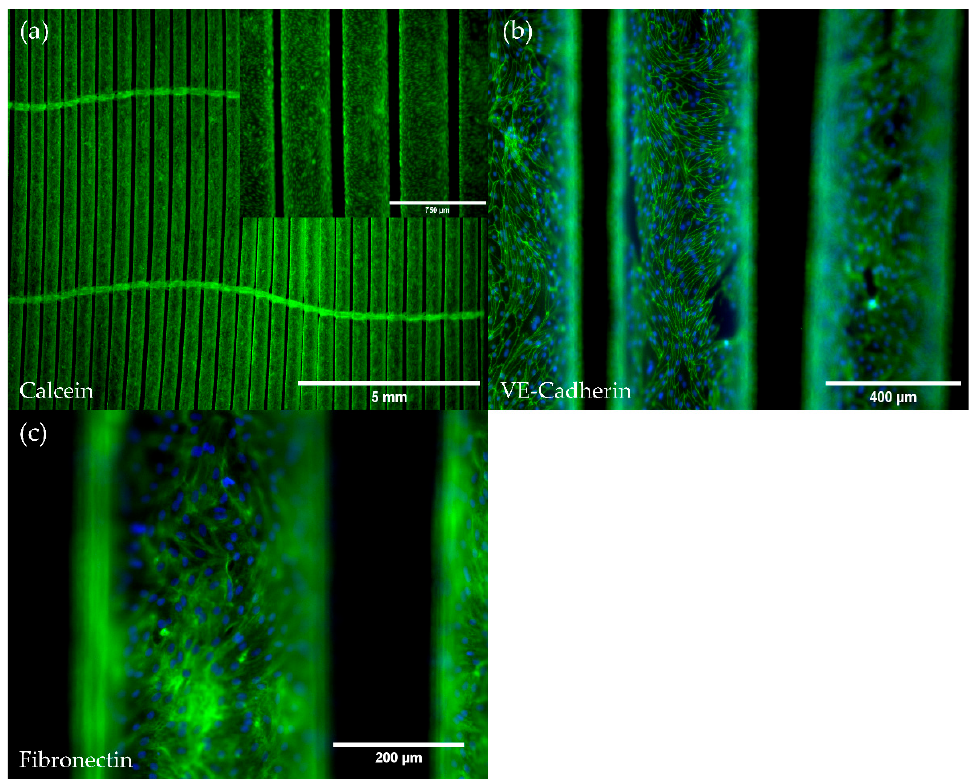
Figure 2. Viability and immunofluorescence staining of pCECs on HFMs. ( a ) Calcein staining of viable pCECs (green) forming a confluent monolayer on the HFM; ( a ) Insert depicts higher magnification; ( b , c ) Immunofluorescence staining for the detection of ( b ) VE-Cadherin (green) and ( c ) the de novo synthesized extracellular matrix protein fibronectin (green); ( b , c ) Corresponding nuclei were counterstained with Hoechst 33342 (blue).